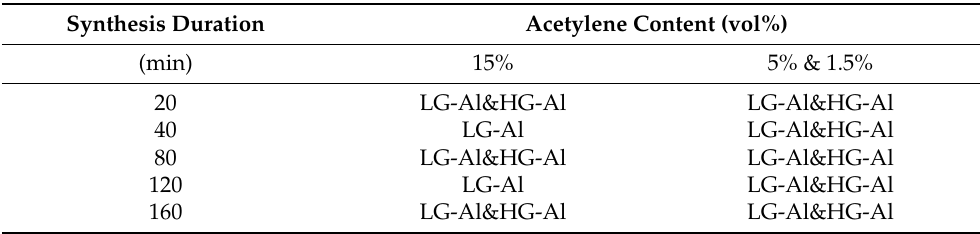
Table 1. Synthesis durations and acetylene concentrations used for the different experiments per- formed. LG-Al and HG-Al stand for Low-Grade and High-Grade aluminum substrate, respectively. Synthesis Duration